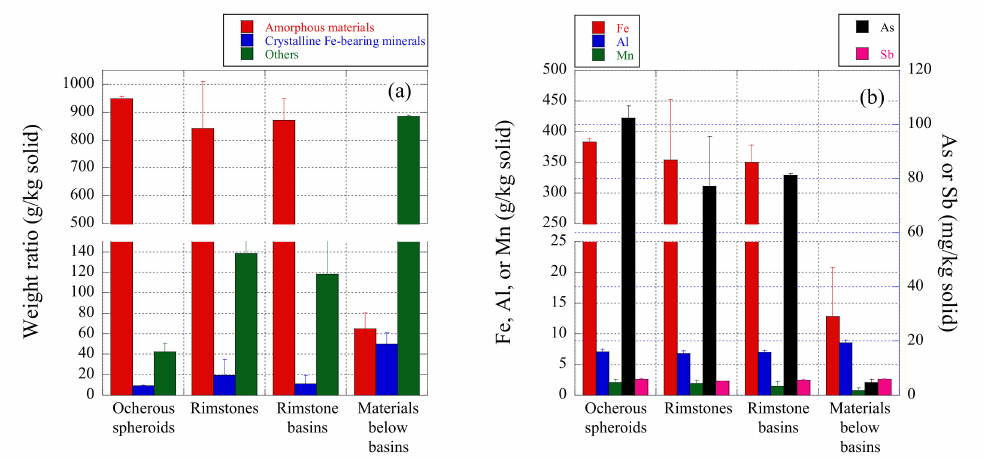
Figure 5. Weight ratio and element content in the four parts of the aggregate. ( a ) Weight ratios of amorphous materials, crystalline Fe-bearing minerals, and other minerals. ( b ) Fe, Al, Mn, As, and Sb